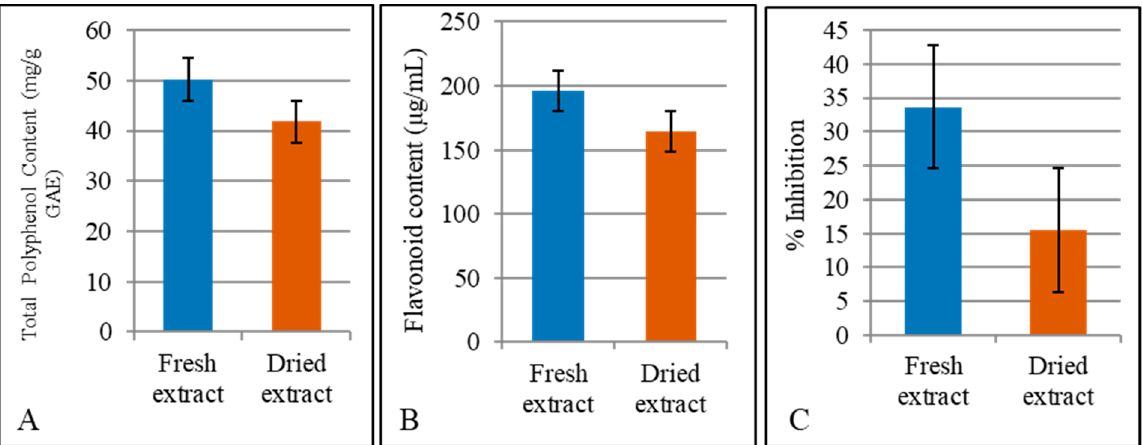
Figure 2. Bioactive compounds and antioxidant activity in the fresh and dry leaf extracts of S. havanensis . ( A ). Total Polyphenol Content of fresh and dried extracts expressed as mg/g of gallic acid equivalent (GAE mg/g) ( B ). Estimation of Total Flavonoid Content of expressed as µg/Ml ( C ). TROLOX Equivalent Antioxidant Capacity (TEAC) assay of dry and fresh extracts as percent inhibition.